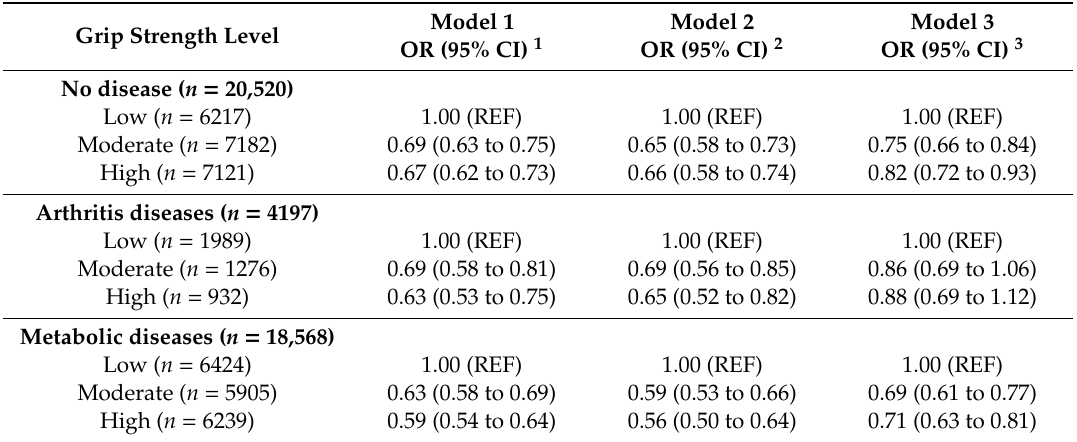
Table 2. Logistic regression models for the association of relative grip strength with depression by disease